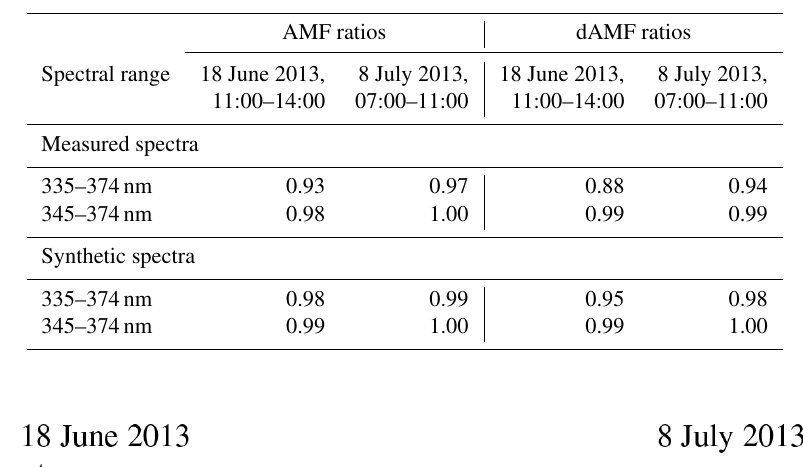
Table A14. Average ratios of O 4 (d)AMFs derived for different fit windows vs. those for the standard fit window (352–387nm) for the middle period of each selected day (top: results for spectra measured by the MPIC instrument; bottom: results for synthetic spectra when taking into account the temperature dependence of the O 4 cross section).